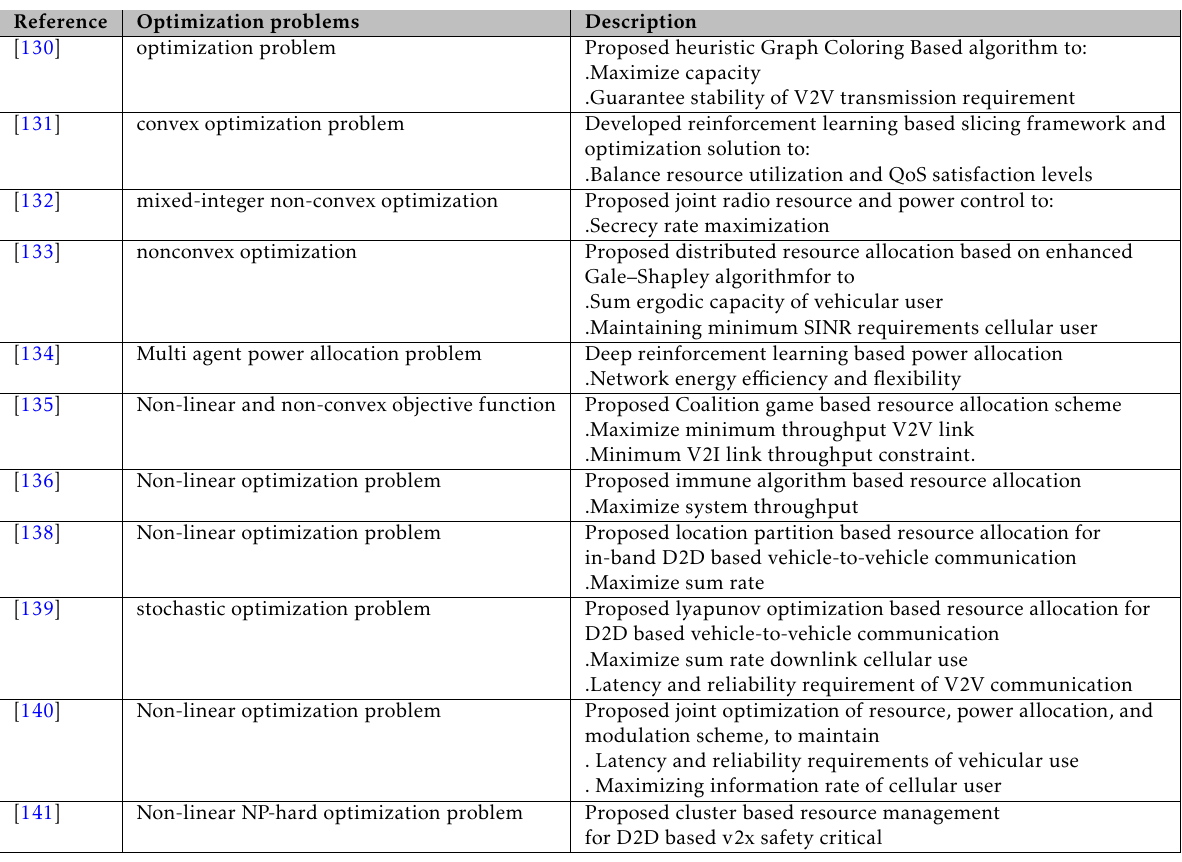
Table 6. Resource Optimization for D2D-based Vehicular Communication